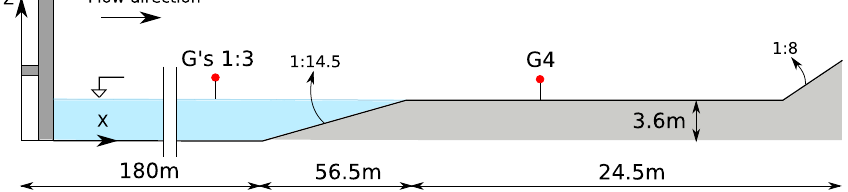
Fig. 3 Solitary wave example. Schematic side view of the experimental flume studied. Units in m. The approximate position of the different wave gauges is also depicted